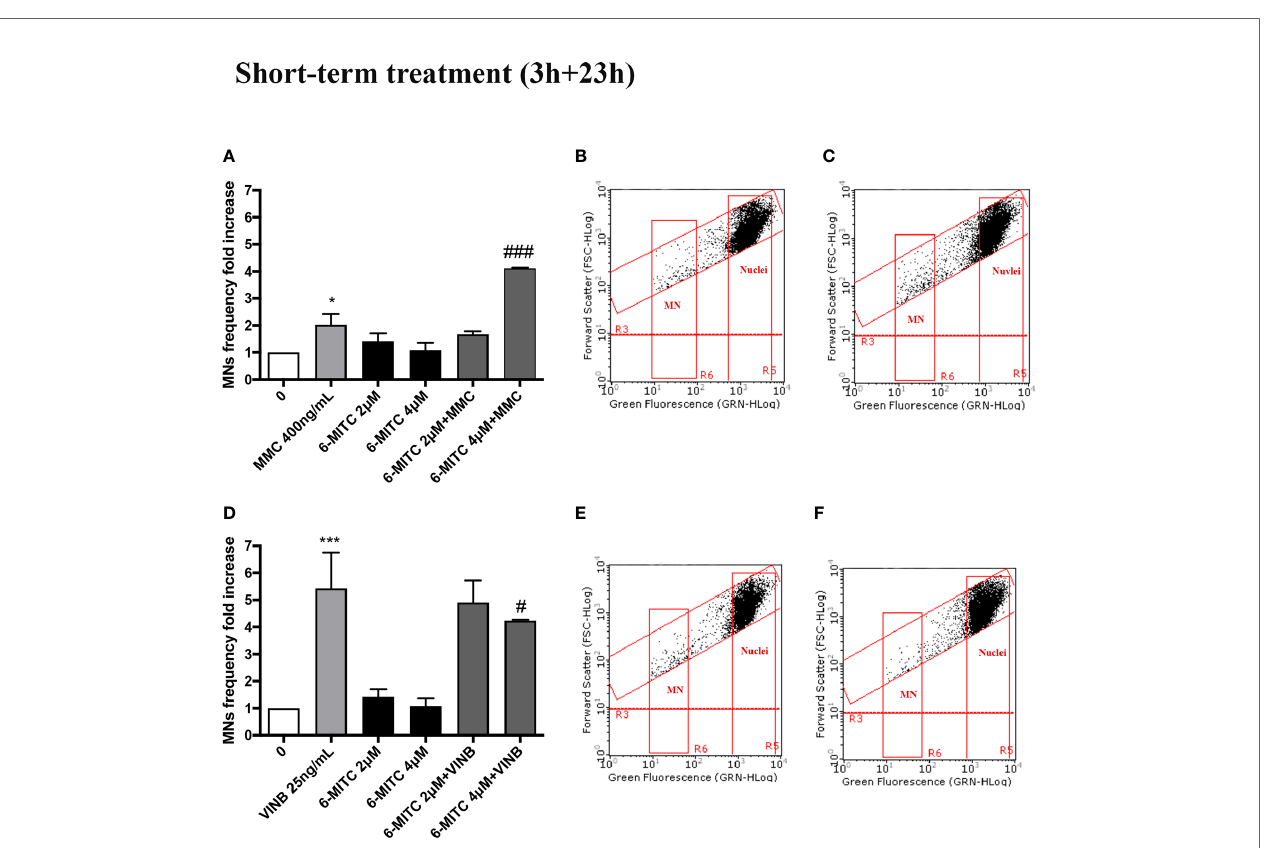
FIGURE 10 | Effect of 6-MITC on antimutagenesis after short term treatment. MNs frequency fold increase on TK6 cells treated for 3h with 6-MITC, followed by 23h of recovery in complete medium, in presence or absence of MMC 400ng/mL (A) or VINB 25ng/mL (D) . Dot plot obtained by FCM of MMC 400ng/mL (B) , MMC400ng/mL + 6-MITC 4µM (C) , VINB 25ng/mL (E) and VINB 25ng/mL + 6-MITC 4µM (F) . Each bar represents the mean ± SEM of fi ve independent experiments. Data were analysed using repeated ANOVA followed by Dunnet or Bonfferoni post-test. *p < 0.05 vs 0; ***P < 0.001 vs 0. ### p < 0.001 vs MMC; # p < 0.05 vs VINB.